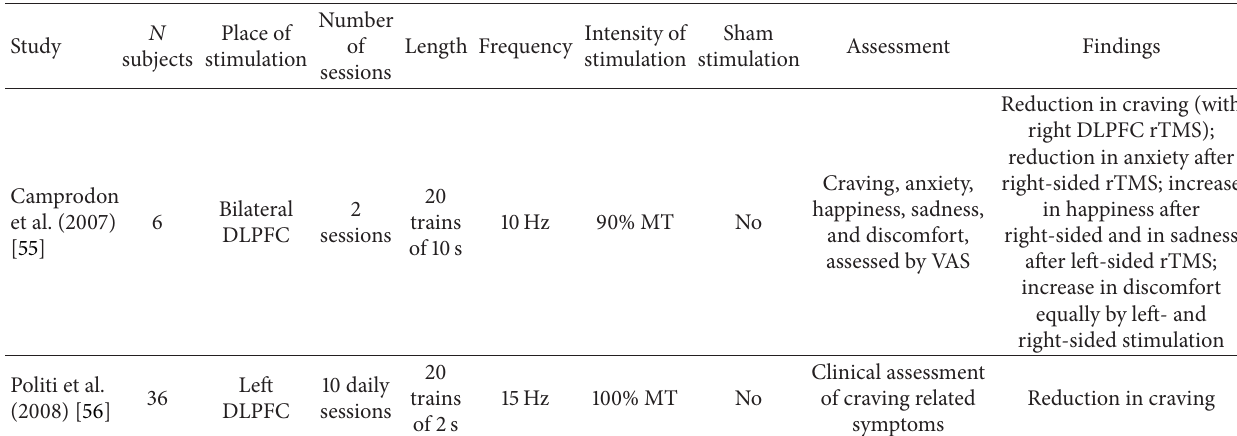
Table 3: Summary of the studies on rTMS in the treatment of cocaine